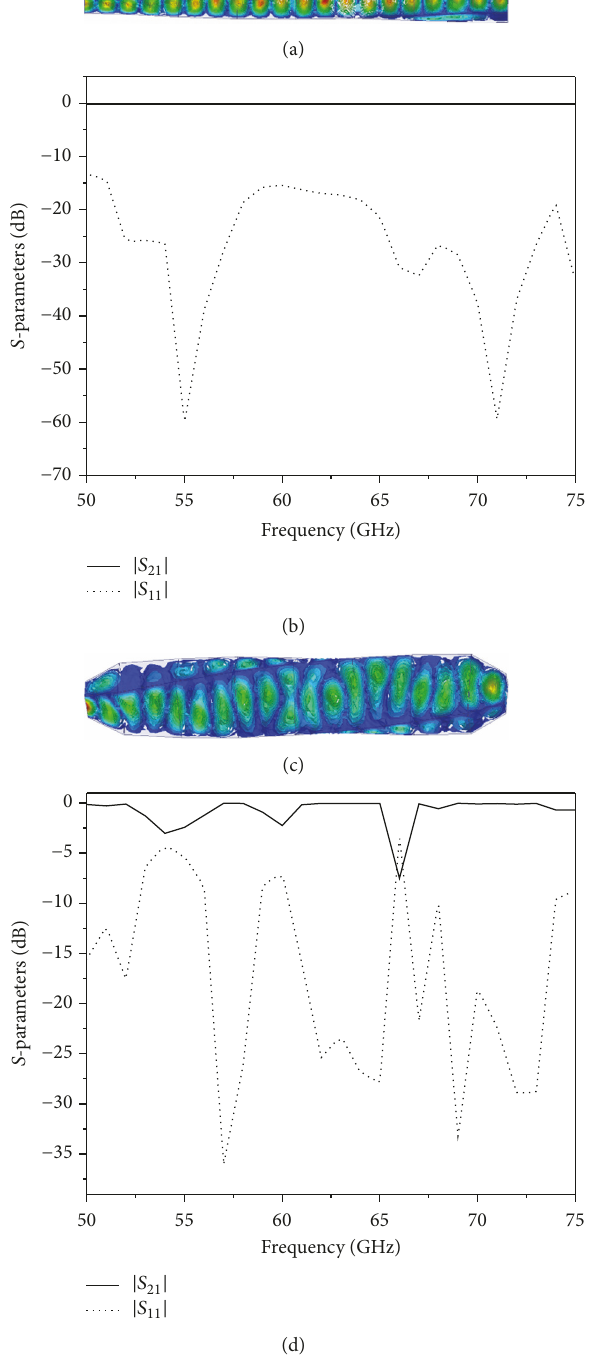
device will become the mainstream solution in both academia and